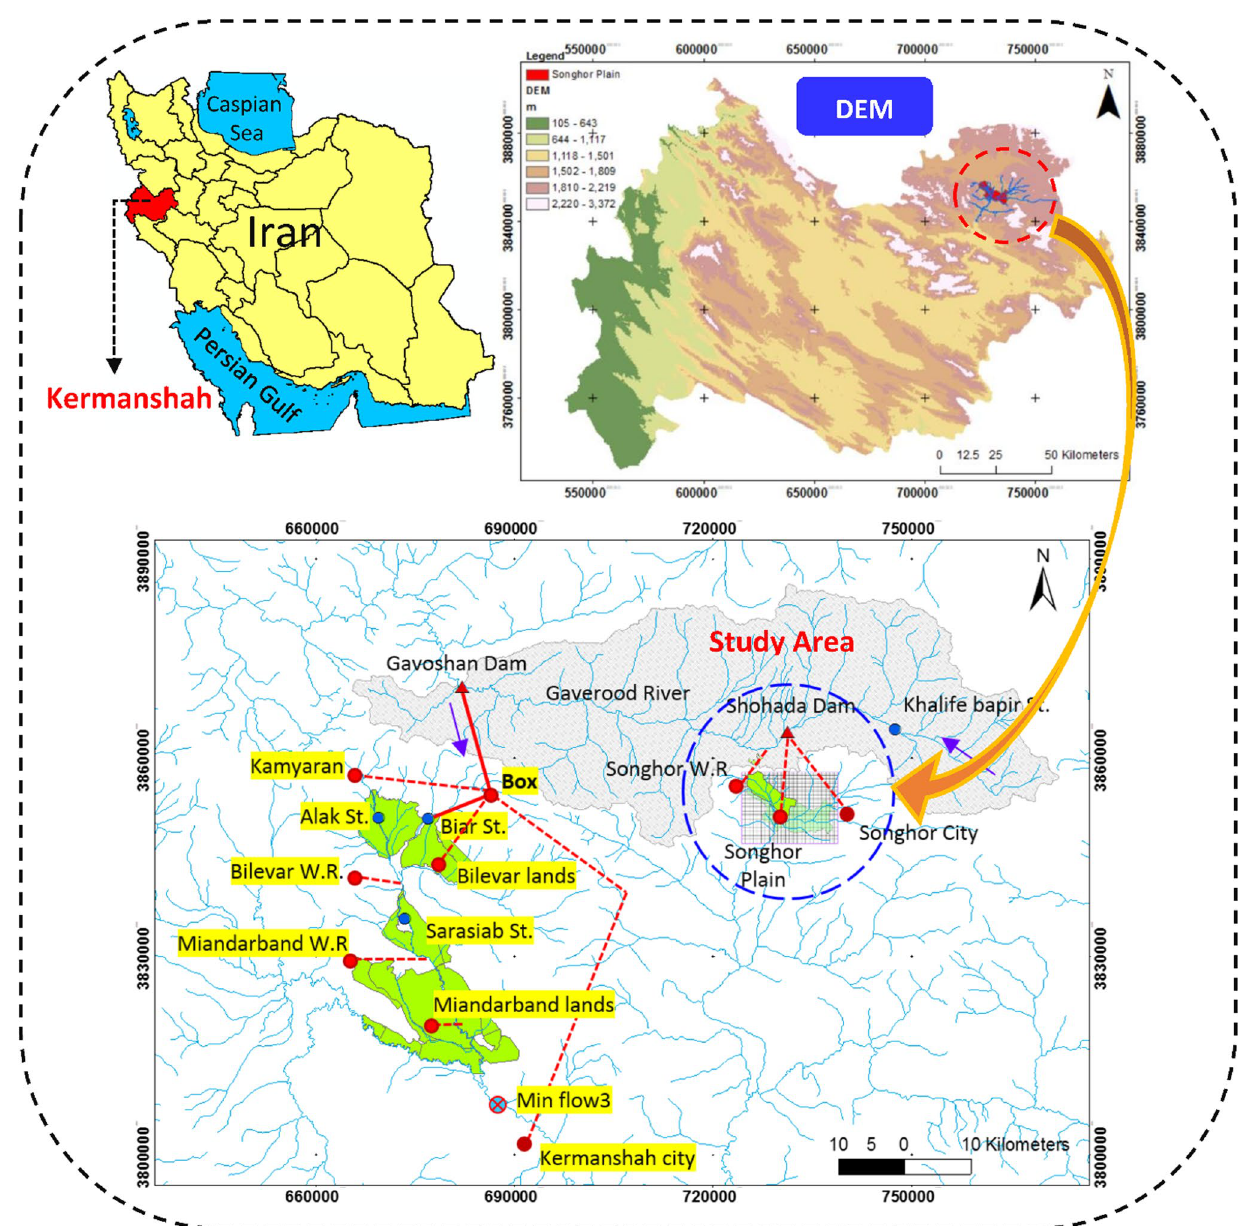
Fig. 1 Location of study area for building a numerical model and artificial intelligence